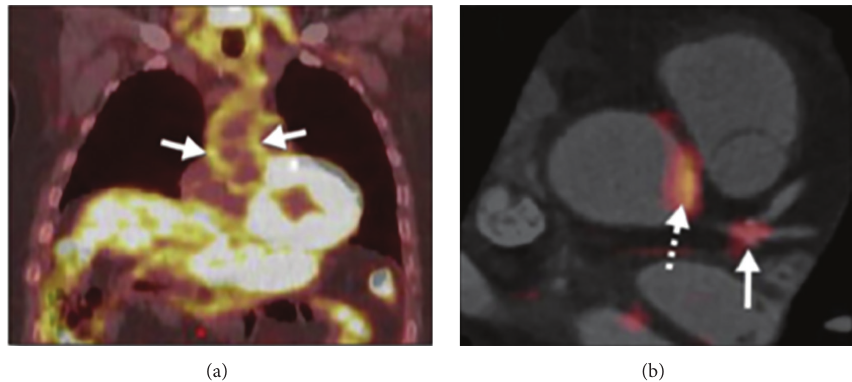
Figure 3: Imaging arterial inflammation using (a) FDG-PET patient demonstrating enhanced aortic uptake of FDG on PET scan, indicating inflammation in the arterial wall due to atherosclerosis. (b) Coregistered FDG-PET/computed tomography images showing FDG uptake at the left main coronary artery trifurcation (solid arrow) in a patient with acute coronary syndrome. Aortic FDG uptake is indicated by the dashed arrow. In such patients, both aortic and coronary artery FDG uptake was increased compared with patients with stable coronary artery disease. Reprinted with permission from Rudd et al.